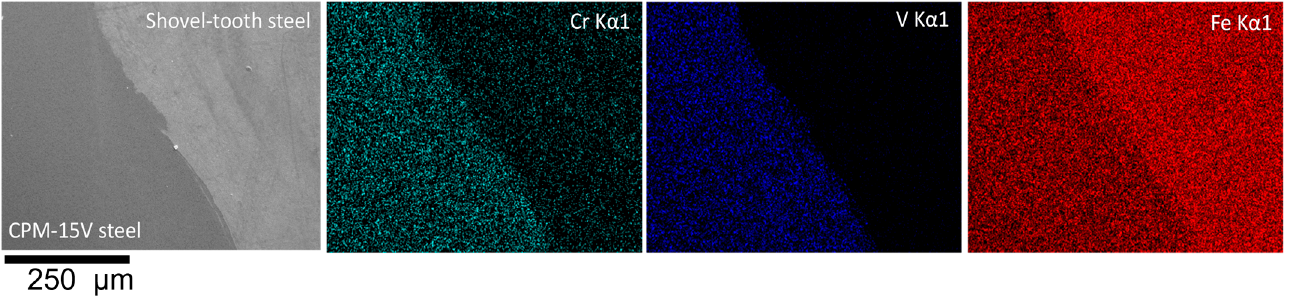
Figure 11. SEM micrograph and EDS maps obtained at the interface for the HF condition .